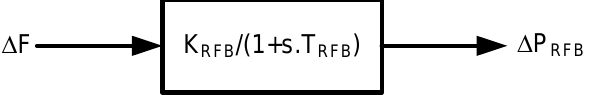
Figure 5. Block diagram of Redox-Flow-Battery (RFB) model.